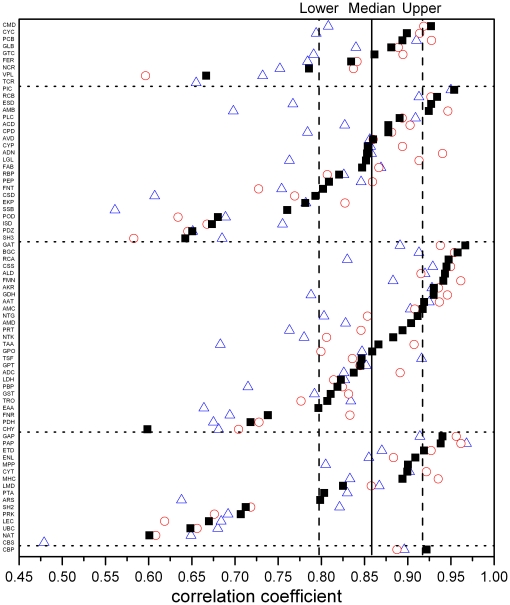
Substitutions and indels are closely related to structural changes.Filled squares show the bilinear multiple correlation coefficients obtained from reasonable structure alignments of families from the “ASTRAL95 select” database. The vertical thick line shows the median bilinear correlation coefficient of 73 families (0.859); the right and left dotted lines show the upper quartile (0.918) and lower quartile (0.798), respectively. Triangles show the bilinear multiple correlation coefficients obtained from all the alignments within each family (75 families). Open circles show the bilinear multiple correlation coefficients obtained from accurate alignments of high-resolution structures (64 families). The five regions from the top to bottom are five SCOP structure classes, which are all α, all β, α/β, α+β and α&β. Abbreviated family names are shown in Table S1.